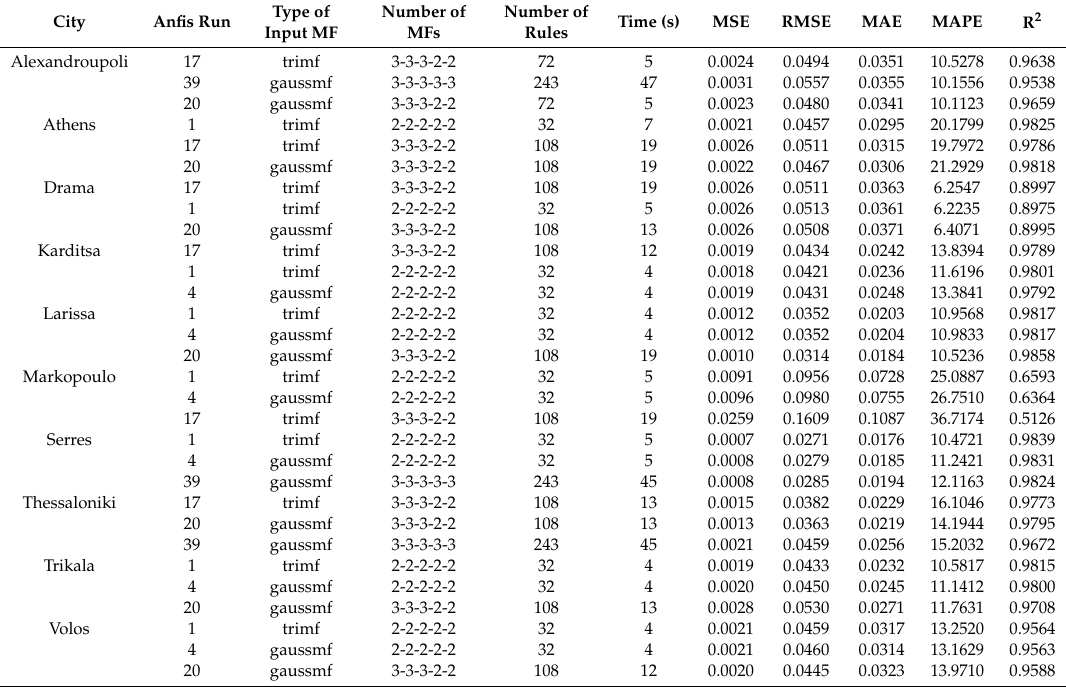
Table 5. Testing results for the best three ANFIS architectures of each city based on MAPE value.